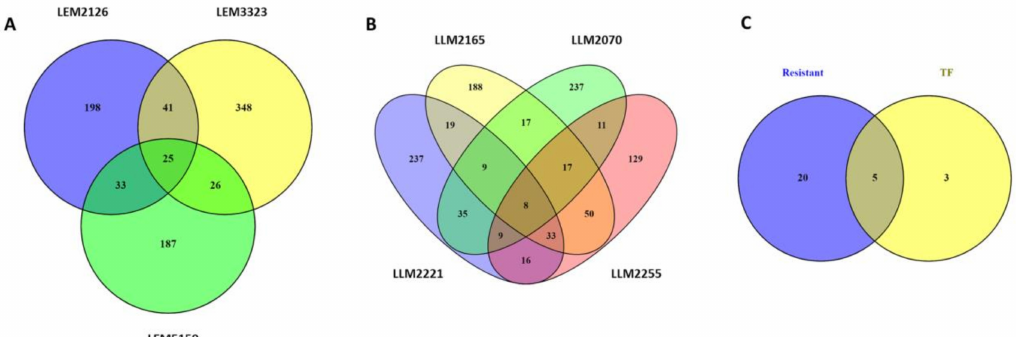
Figure 2. Venn diagrams of differentially expressed genes (DEGs) in L. infantum lines after THP-1 infection. Venn diagrams of ( A ) resistant lines, ( B ) therapeutic failure (TF) lines, and the combina- tion of both ( C ). The number of exclusive and common genes in each comparison, including total upregulated and downregulated DEGs, are